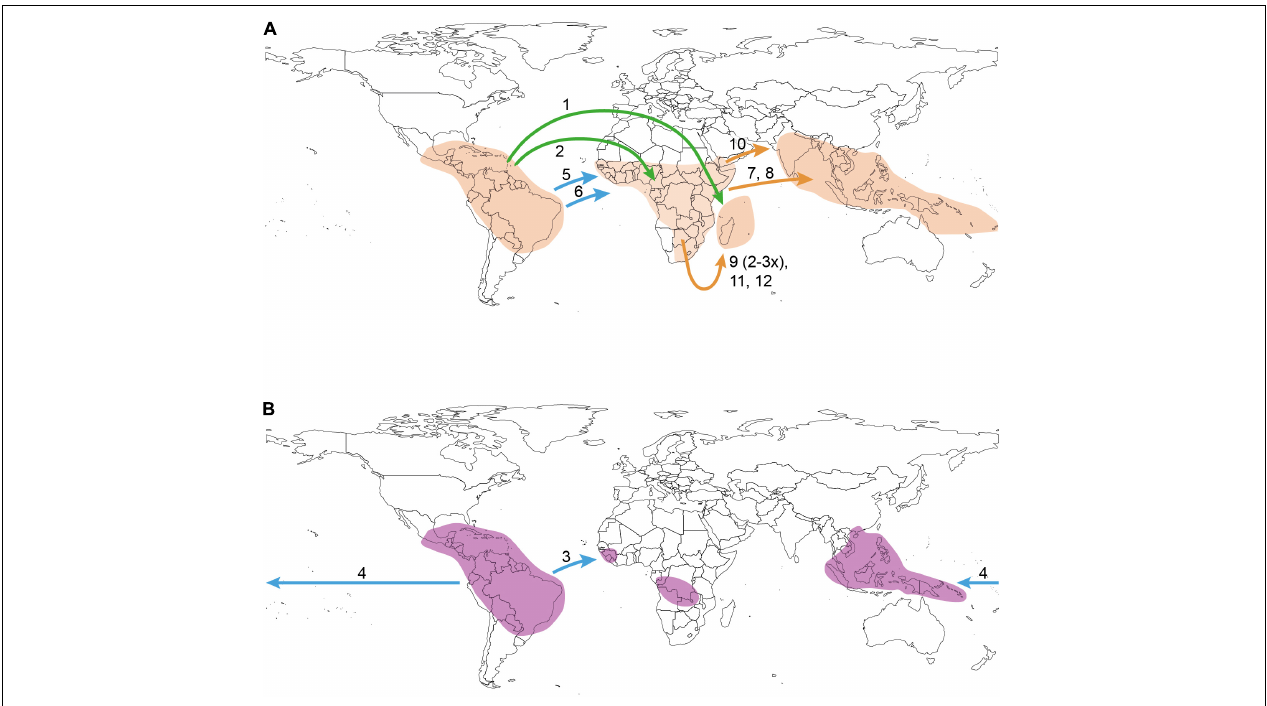
FIGURE 2 | Distribution areas together with the inferred most probable long-distance dispersal (LDD) events of Ochnaceae in Medusagynoideae, Testuleeae, and Ochneae (A) and Sauvagesieae (B) . LDD events and their direction are indicated by arrows; the arrow color indicates the time periods of LDD from old (green, Paleogene) to mid-term (blue) and young (orange = Miocene/Pliocene) events. The numbers at the arrows correspond to the LDD events leading to (1) Medusagyne ; (2) Testulea ; (3) Fleurydora ; (4) SE Asian Sauvagesieae; (5) Lophira ; (6) African Ochninae; (7) Asian Brackenridgea ; (8) Campylospermum serratum ; (9) Malagasy Ochna (multiple LDD); (10) Asian Ochna ; (11) Malagasy Brackenridgea and (12) Campylospermum . Sauvagesieae is species-poor in Africa with one LDD event explaining the distribution of the monotypic Fleurydora (3) in West Africa (the approximate distribution area of Sauvagesia africana is also given on the map, but this species was not included in the present study; the African occurrences of S. erecta are not indicated). The LDD of the African Ochninae (6) was only inferred by the DIVA-like